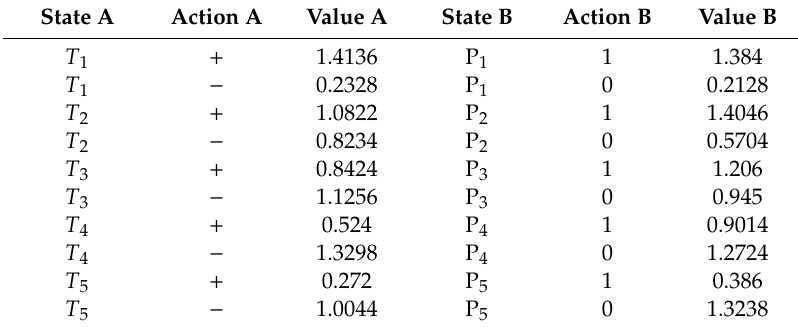
Table 15. Q Function table of the second iteration.